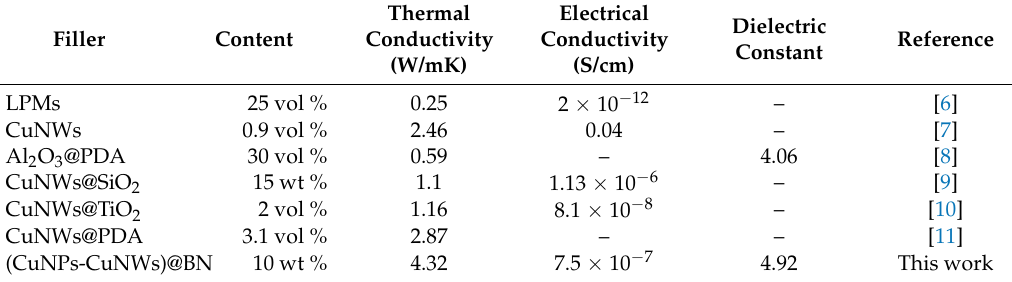
Figure 3. ( a ) Thermal conductivity values and flexural strengths (inset) of pure PI, CuNPs@BN/PI, CuNWs@BN/PI, and (CuNPs-CuNWs)@BN/PI nanocomposites assessed in ambient conditions; ( b ) relative permittivity and dielectric loss for CuNPs@BN/PI, CuNWs@BN/PI, and (CuNPs-CuNWs)@BN/PI films at frequencies between 1 kHz and 1 MHz. Table 1. Thermal conductivity and dielectric features of the composites generated in this and other